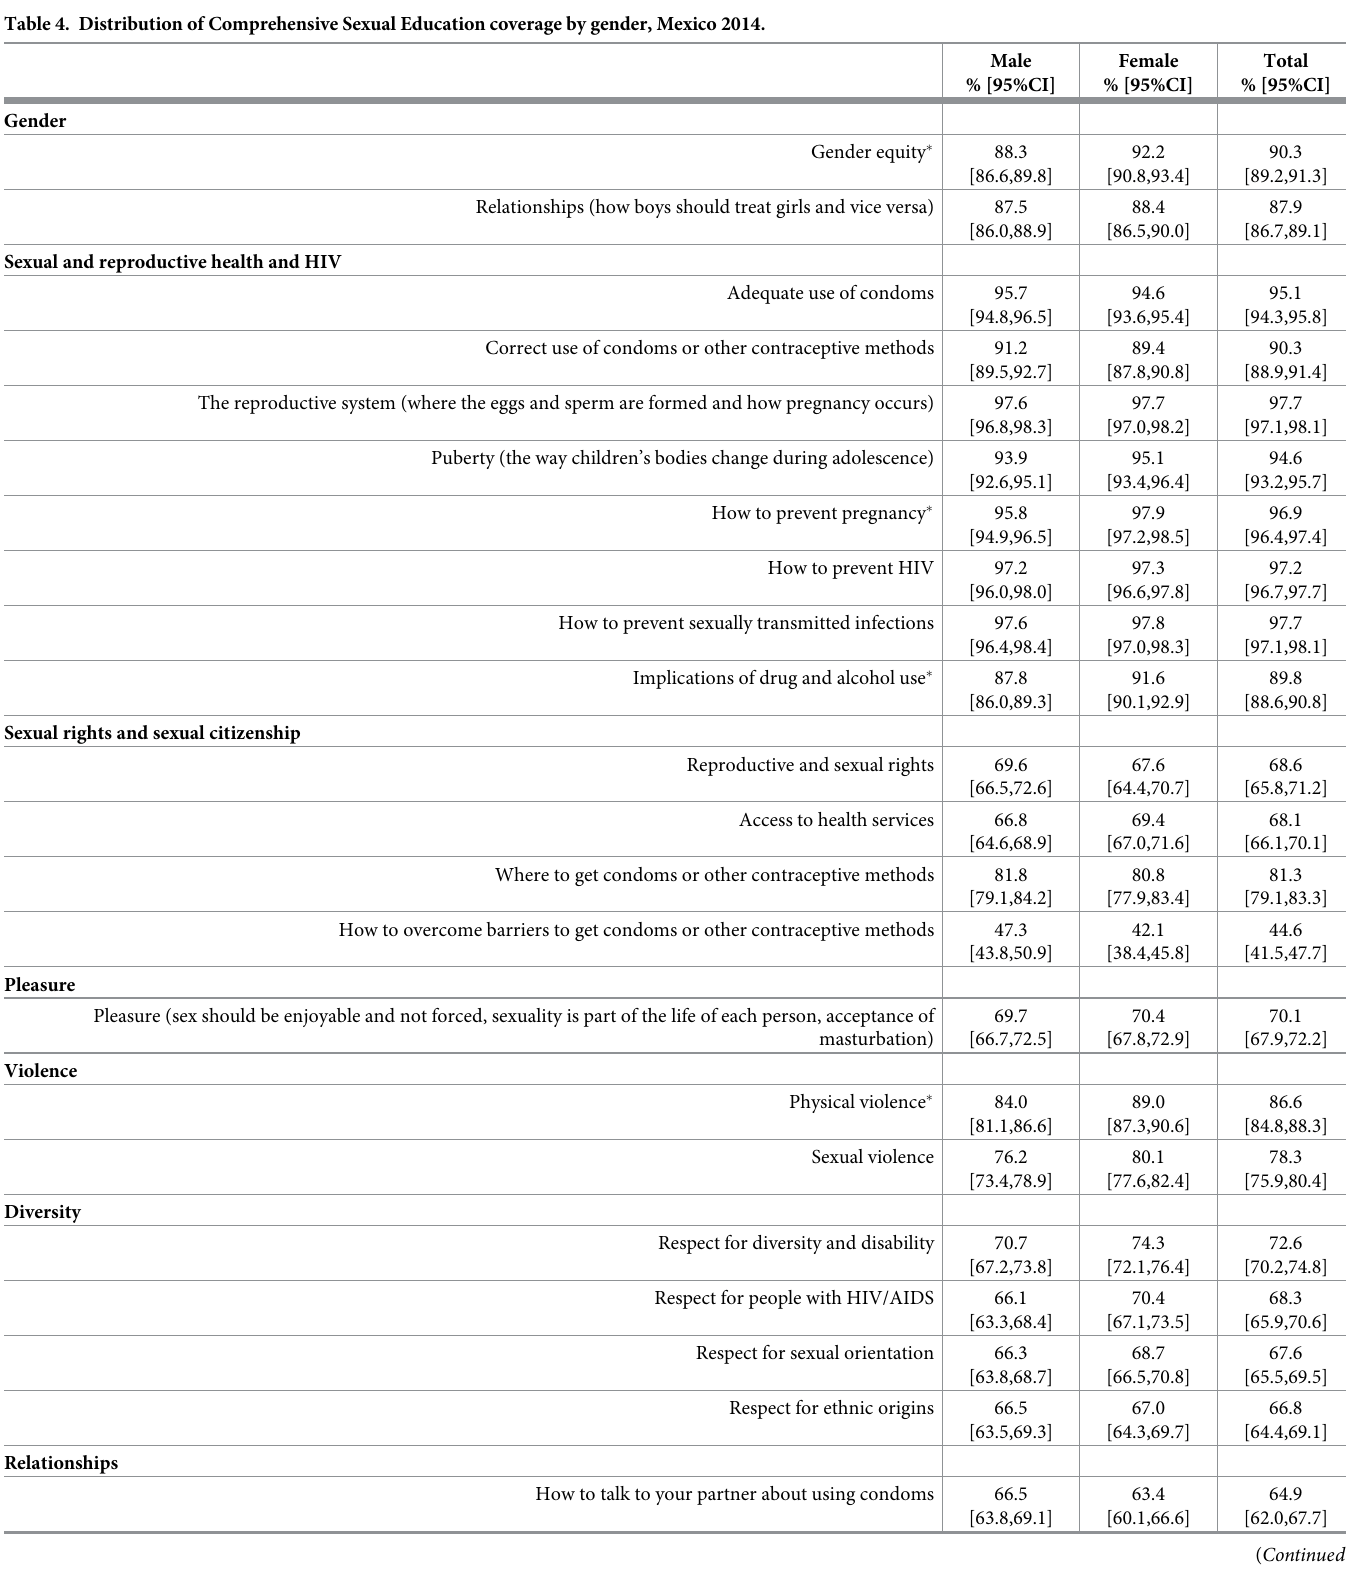
Table 4. Distribution of Comprehensive Sexual Education coverage by gender, Mexico